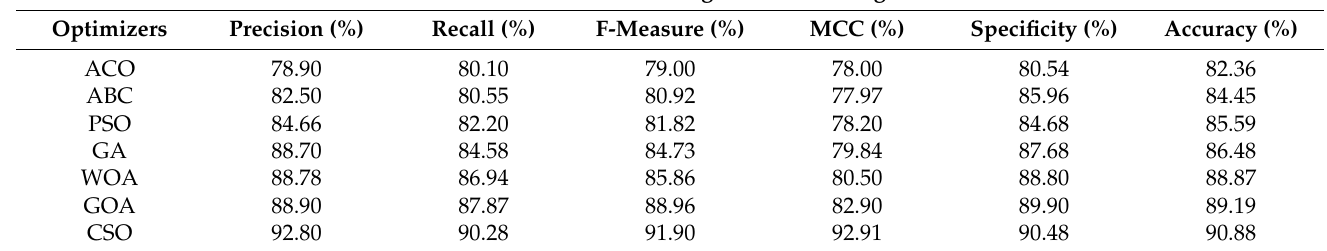
ture optimization algorithms, such as Ant Colony Optimization (ACO), Artificial Bee Col ‐ ony (ABC), Particle Swarm Optimization (PSO), Genetic Algorithm (GA), Whale Optimi ‐ zation Algorithm (WOA), CSO, and Grasshopper Optimization Algorithm (GOA) with OGRU model. Related to other combinations, the CSO algorithm with the OGRU attained higher results in intracranial hemorrhage detection. In this paper, the CSO algorithm sig ‐ nificantly selects the optimum feature vectors with a better balance between exploitation and exploration. However, the comparative optimization algorithms suffer from a prem ‐ ature convergence rate because the optimization algorithms are stuck at the local optimal value. As seen in Tables 3 and 4, the proposed OGRU ‐ CSO model obtained significant performance with 80:20% training and testing of RSNA 2019 brain CT hemorrhage data compared to 50:50% training and testing of data. The graphical representation of dissimilar optimizers with 50% training and 50% testing of data is specified in Figure 9. Correspondingly, the graphical comparison of dissimilar optimizers with 80% training and 20% testing of data is denoted in Figure 10. Table 3. Simulation results of the proposed model by varying the optimizers with 50:50% training and testing of data.